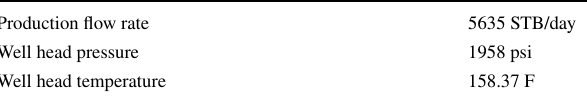
Fig. 8 Fluid viscosity profile in the well for choke size of 44/64 inches Table 9 Results of nodal analysis simulation Production flow rate